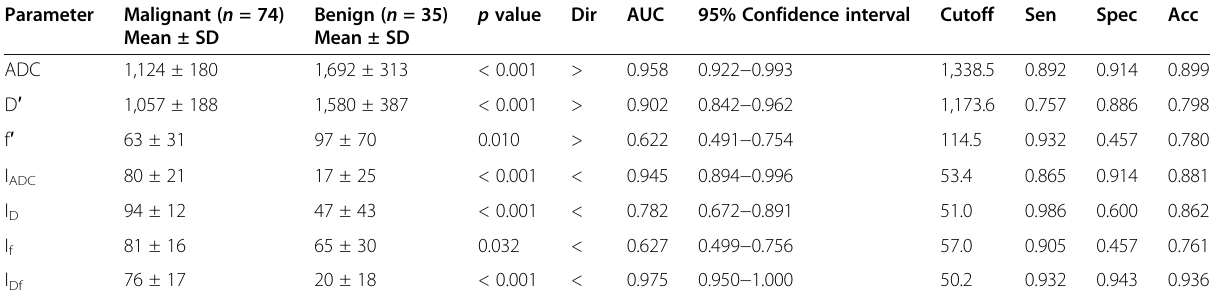
Table. 4 Receiver operating characteristic analysis for differentiation of malignant from benign liver lesions Parameter